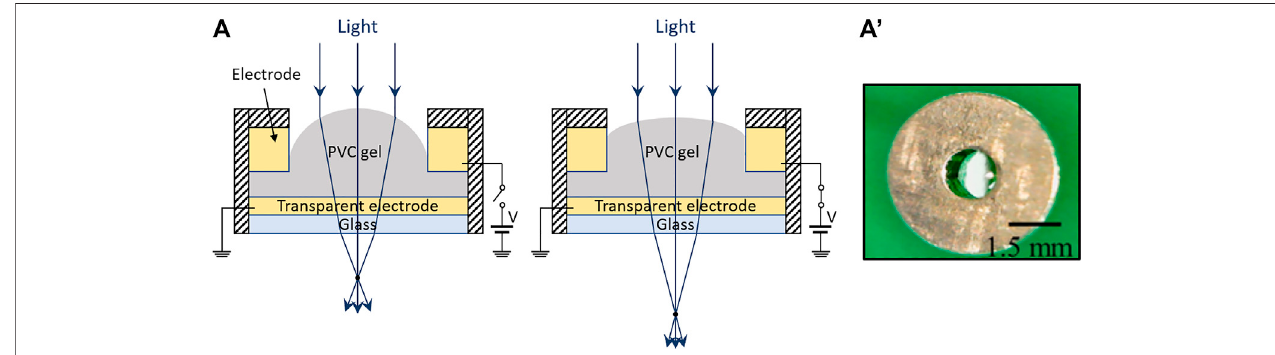
FIGURE 6 | Electrically deformed elastomeric lens, consisting of an electrically sensitive PVC gel. (A) Schematic of a possible structure (example among various alternatives)andrelatedprincipleofoperation:anappliedvoltagecreatesanon-uniformelectric fi eld,whichdeformsthelens-shapedblockofgel,changingitscurvature. (A 9 ) Prototype sample, reproduced with permission from (Bae et al.,